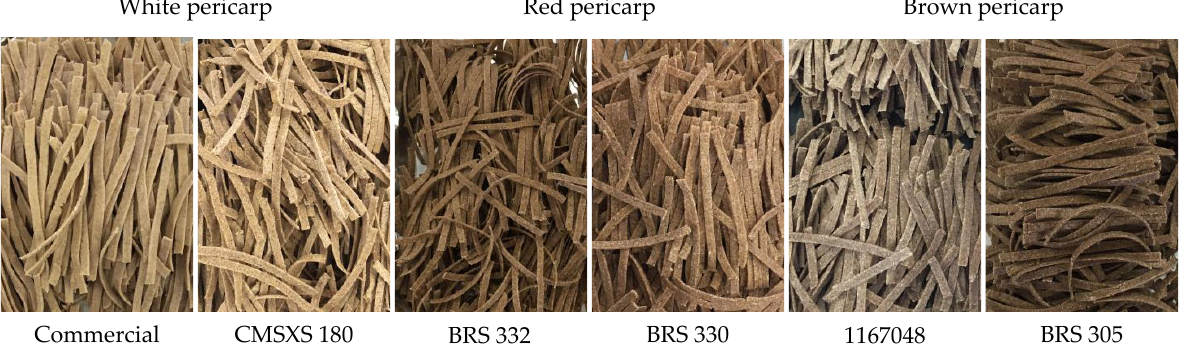
Figure 1. Sorghum pastas used six hybrids with three pericarp colors.